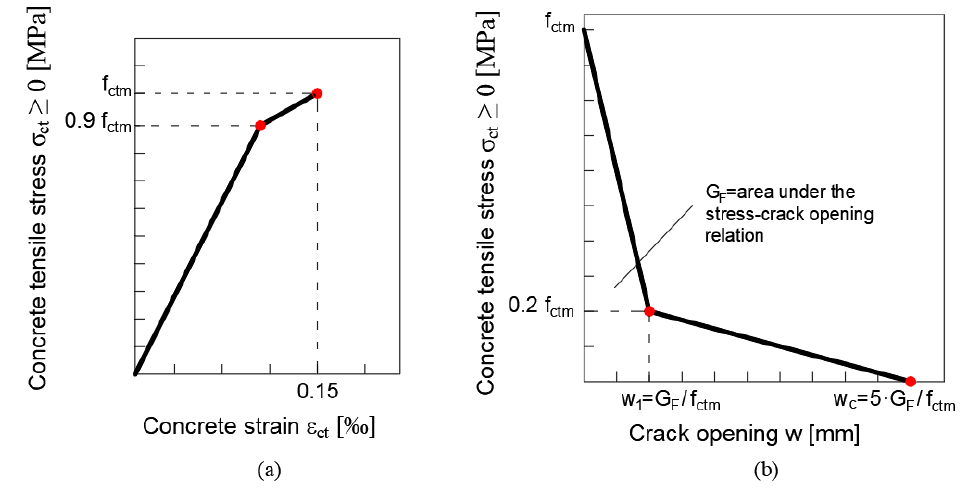
Figure 6. Schematic graph of the stress–strain relation for uniaxial tension: ( a ) for ε k ≤ 0.00015, the stress–strain behaviour is described by a bilinear relation; ( b ) for ε k > 0.00015, the stress–strain behaviour is described by a softening constitutive stress–crack opening law.